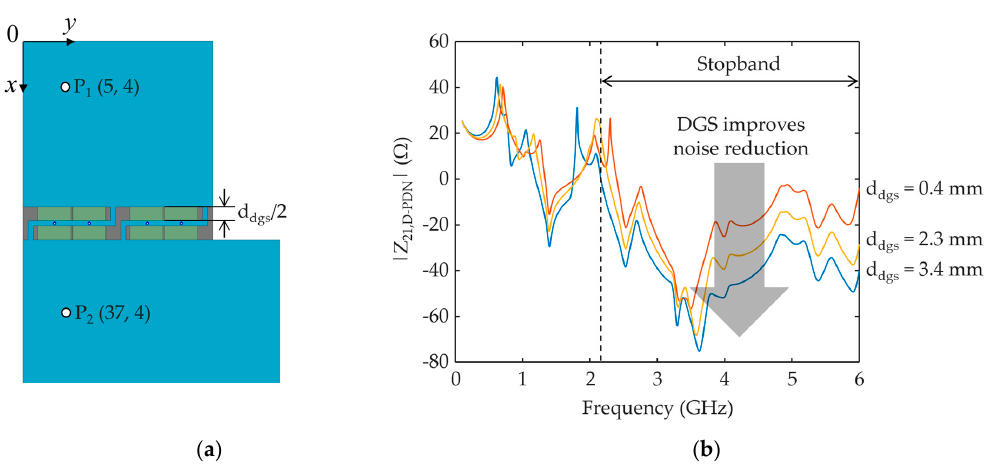
Figure 17. ( a ) DGS–EBG-based PDN with two ports and ( b ) Z 21 results from the proposed DDM for analysis of DGS effect on noise reduction between D- and NS-PDNs.